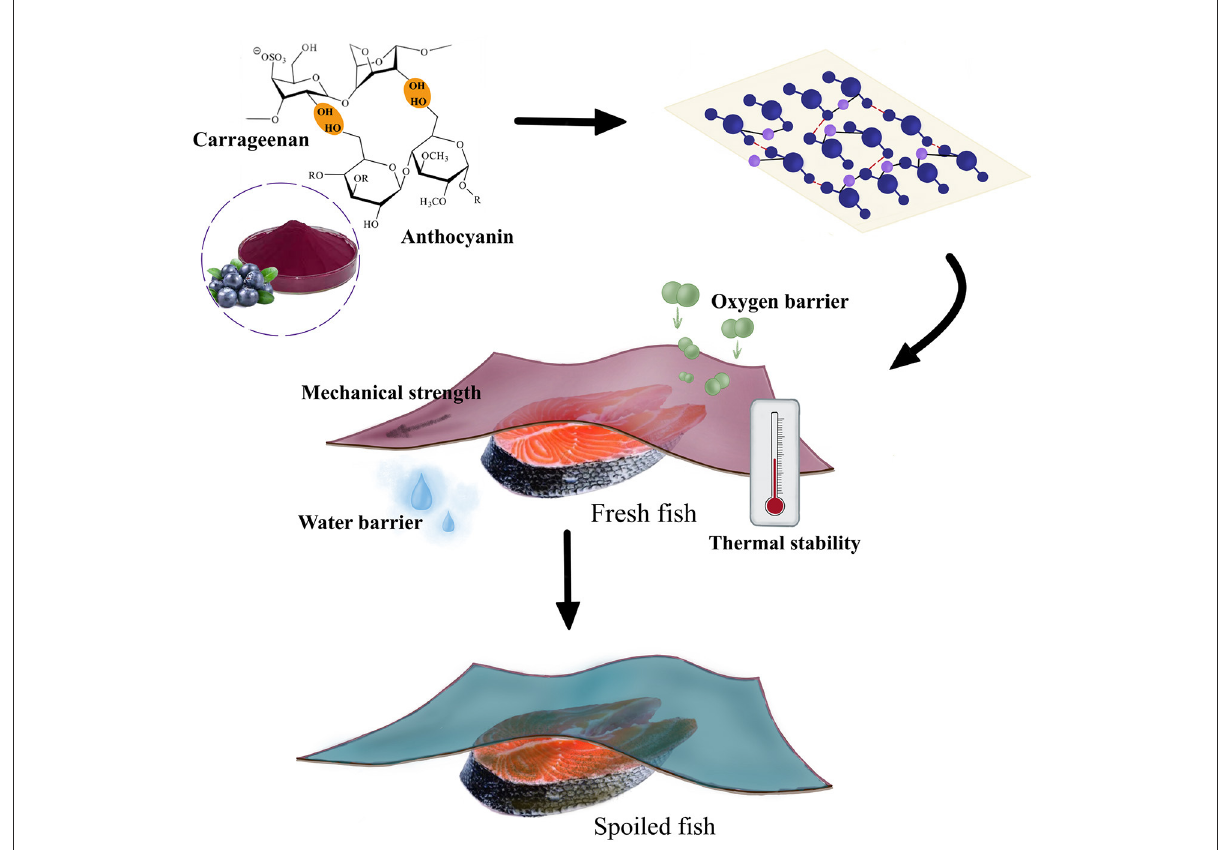
FIGURE6 Schematic diagram of the application of the anthocyanin-carrageenan film for monitoring fish freshness.